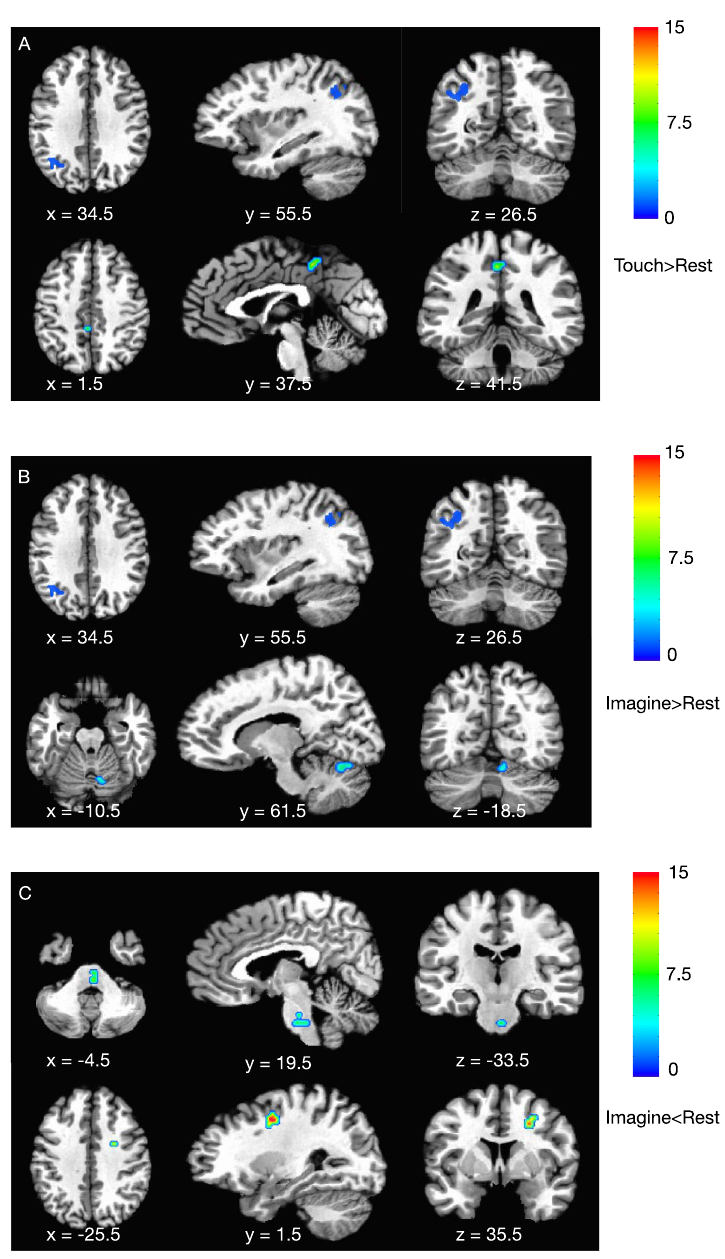
Figure 3. Clusters that survived Hommel’s method. ( A ) Left IPS and left middle cingulate cortex were higher with sensory trick performance in patients. ( B ) Left IPS and right cerebellum were higher with trick imagination in patients. ( C ) Pons and right middle frontal gyrus were lower with trick imagination in